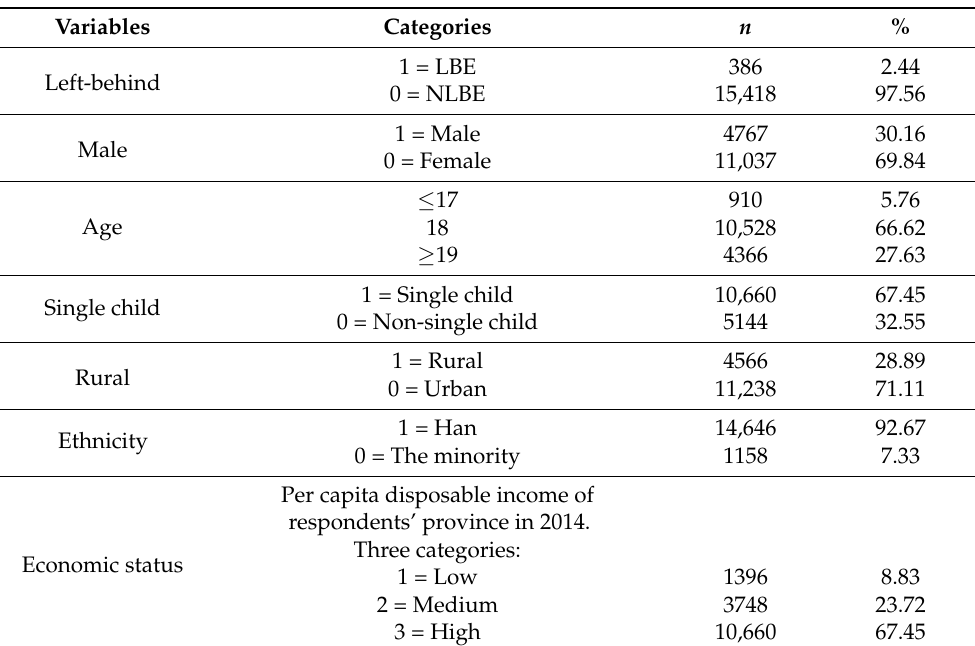
Table 1. Variable descriptions and participants’ demographic characteristics.